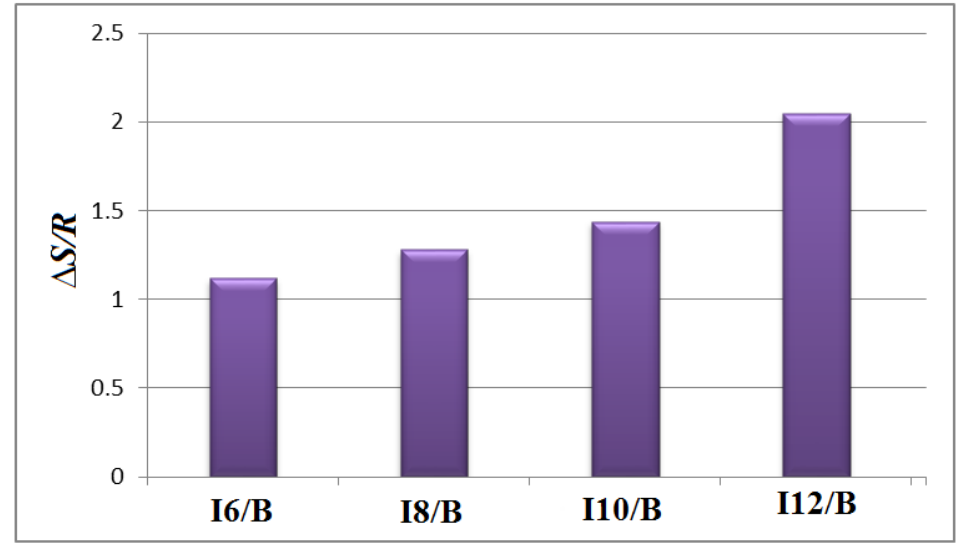
Figure 5. Normalized entropy changes with the alkoxy chain length of SMHB In / B complexes.